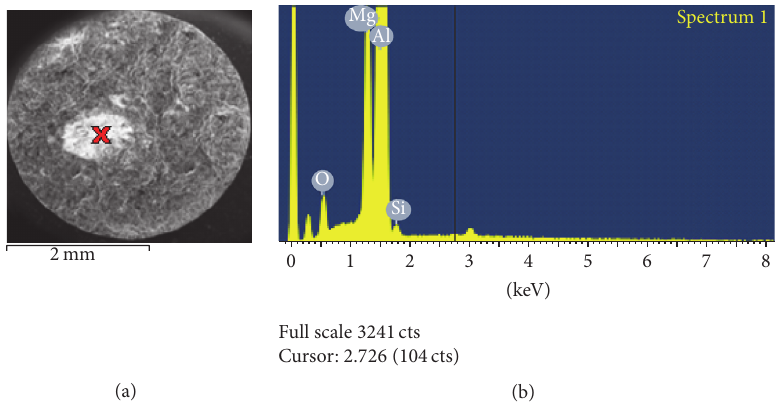
Figure 8: (a) An SEM image of the fracture surface of a specimen from Experiment 3; (b) EDX analysis at the location marked “X” in (a).